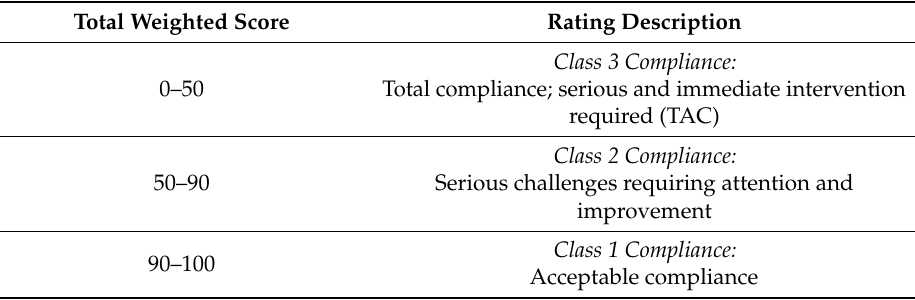
Table 3. Technical compliance rating of the treatment plants